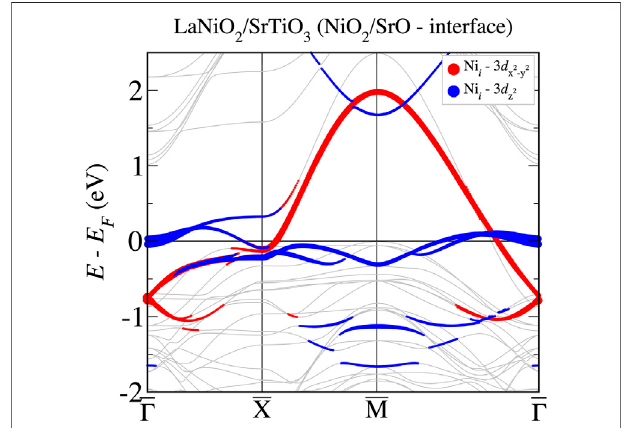
FIGURE 2 | Electronic band structure of the LaNiO 2 /SrTiO 3 heterostructure for the NiO 2 /SrO interfacial con fi guration (the colors highlight the main contributions of the interfacial Ni-3 d states near the Fermi level and a 3/3 superlattice is considered). The effective interfacial doping for this con fi guration depletes the self-doping from the R -5 d states characteristic of the bulk and places the Ni-3 d z 2 states at the Fermi level introducing fl atband features. Adapted from